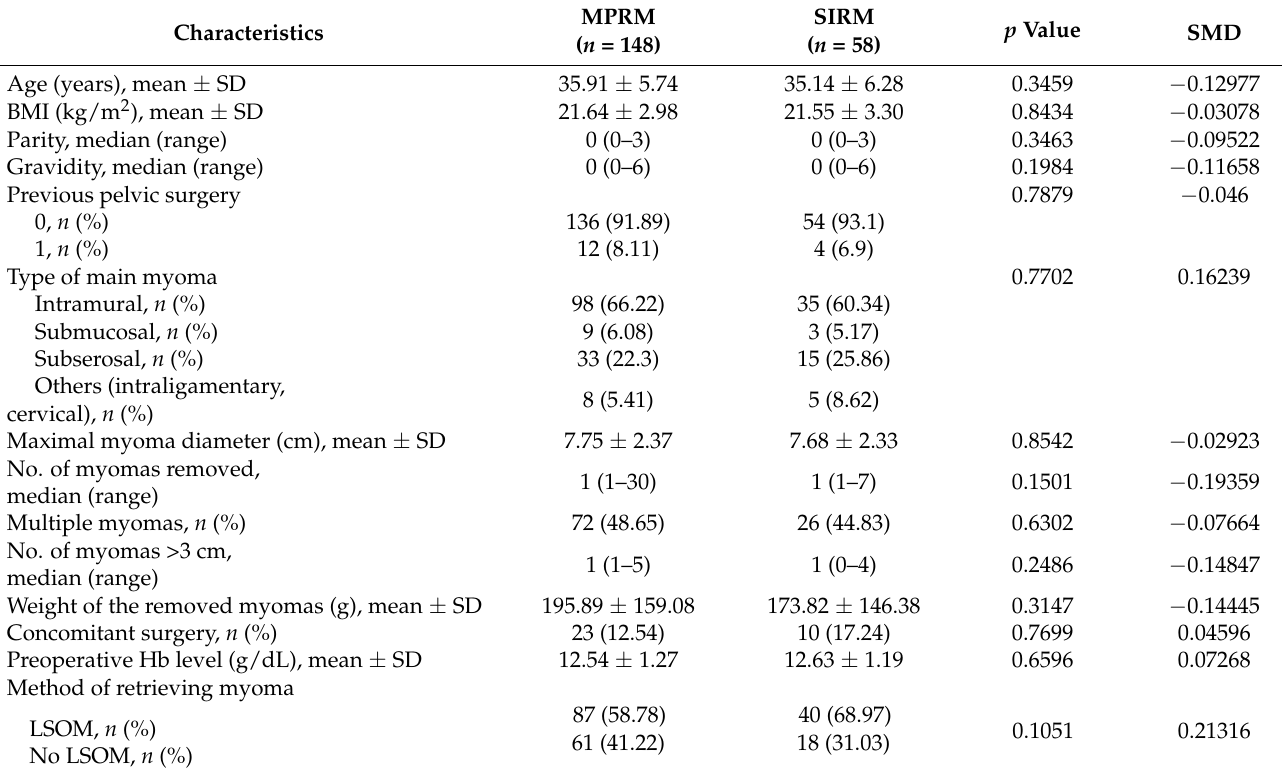
Table 2. Baseline and preoperative patient characteristics after 1:3 propensity score